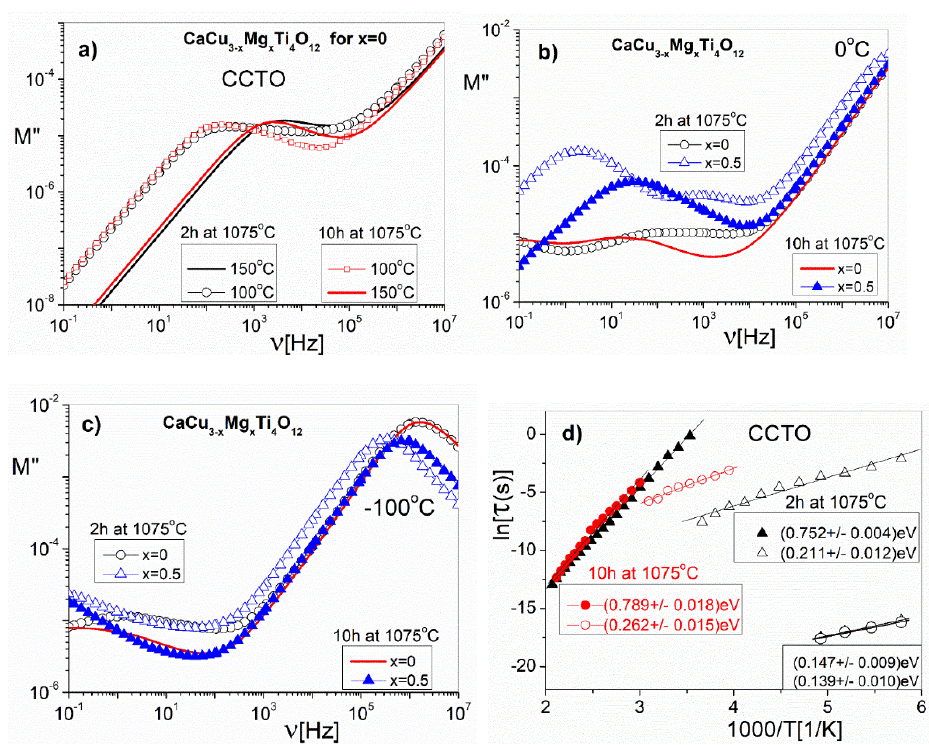
Figure 9. Frequency dependence of the imaginary part of the electric modulus (M’) of the CCTO (sintered at 1075 ◦ C for 2 h and 10 h) samples at two chosen temperatures ( a ); CaCu 3 − x Mg x Ti 4 O 12 (for x = 0 and x = 0.5) at a 0 ◦ C temperature ( b ); CaCu 3 − x Mg x Ti 4 O 12 (for x = 0 and x = 0.5) at a − 100 ◦ C temperature ( c ); and the temperature dependence of the relaxation times obtained from the frequency-dependent plots of M” ( d ).